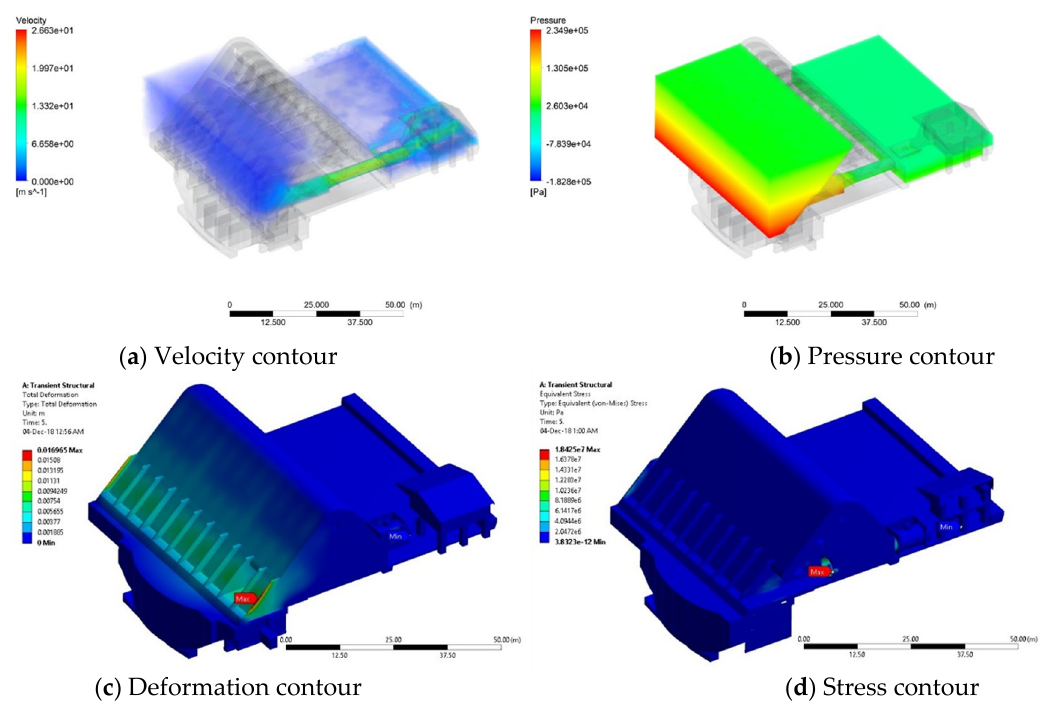
Figure 11. Contours on the bottom outlet with fully closed butterfly valve.